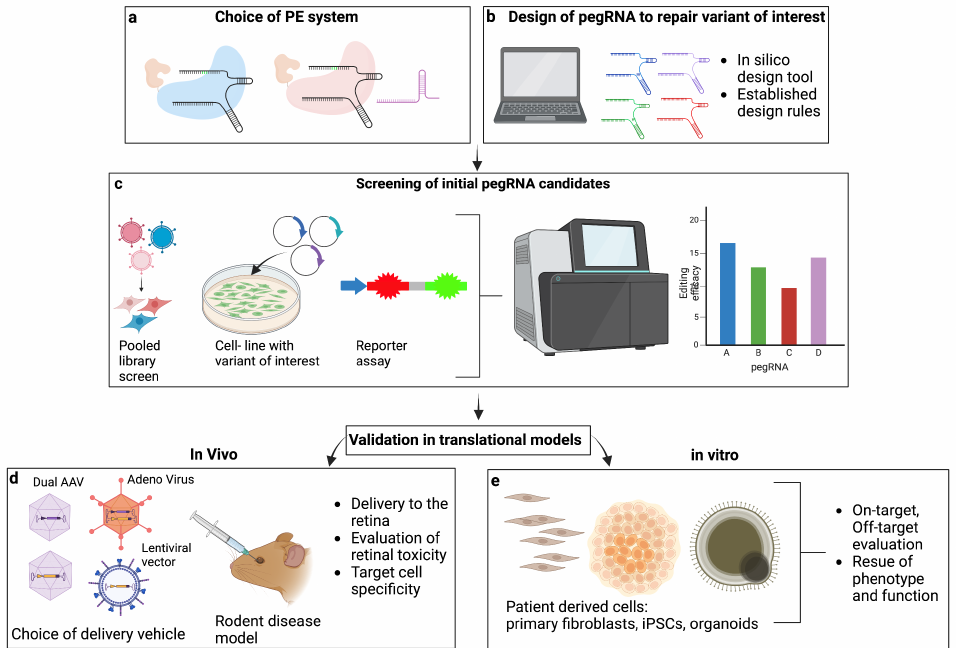
Figure 4. Workflow for the development and validation of prime editing as a treatment approach to target pathological variants causative for IRD. ( a ) A suitable prime editing system (i.e., PE2, PE3) and PE architecture (i.e., PEmax) are chosen. ( b ) pegRNAs to repair the variant of interest are designed using established designrules and in silico tools. ( c ) An initial screen of pegRNA candidates is performed using cell-lines containing the variant of interest or a reporter assay. Alternatively, a high throughput screen based on a pooled lentiviral library can be employed. Prime editing efficacy is evaluated by NGS or sanger sequencing. ( d , e ) The best performing pegRNAs are validated in translational models in vivo and in vitro. ( d ) Rodent disease models can be used to test